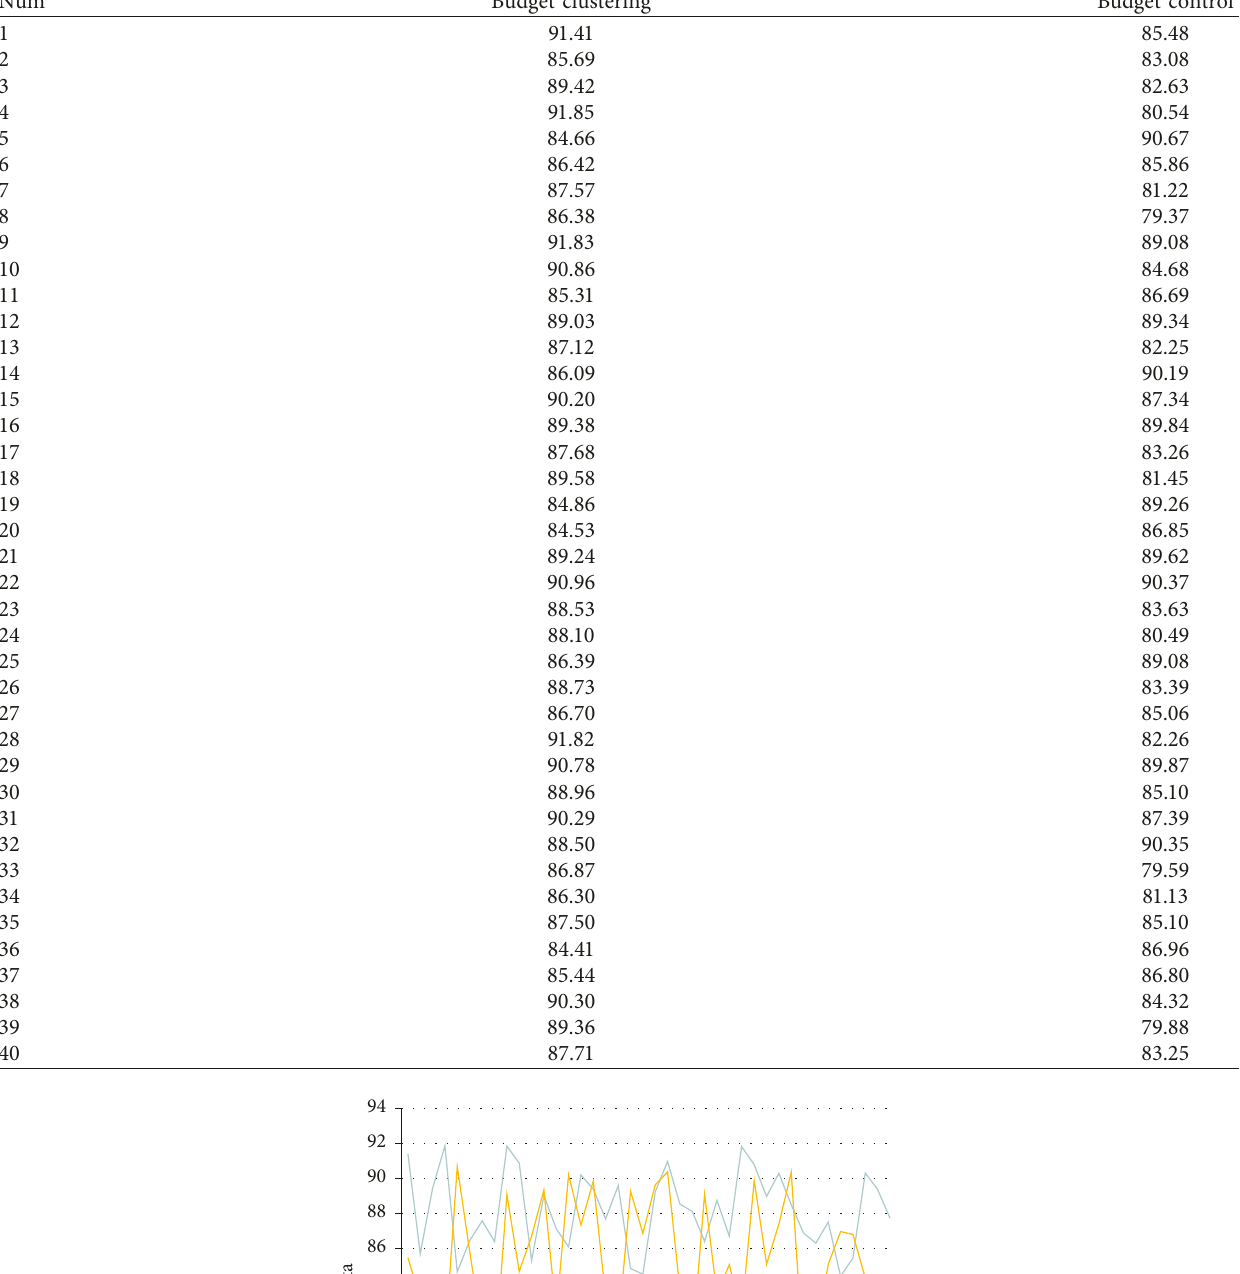
Table 1: Evaluation of the budget control effect of the construction cost budget control system based on the dynamic distributed clustering algorithm.